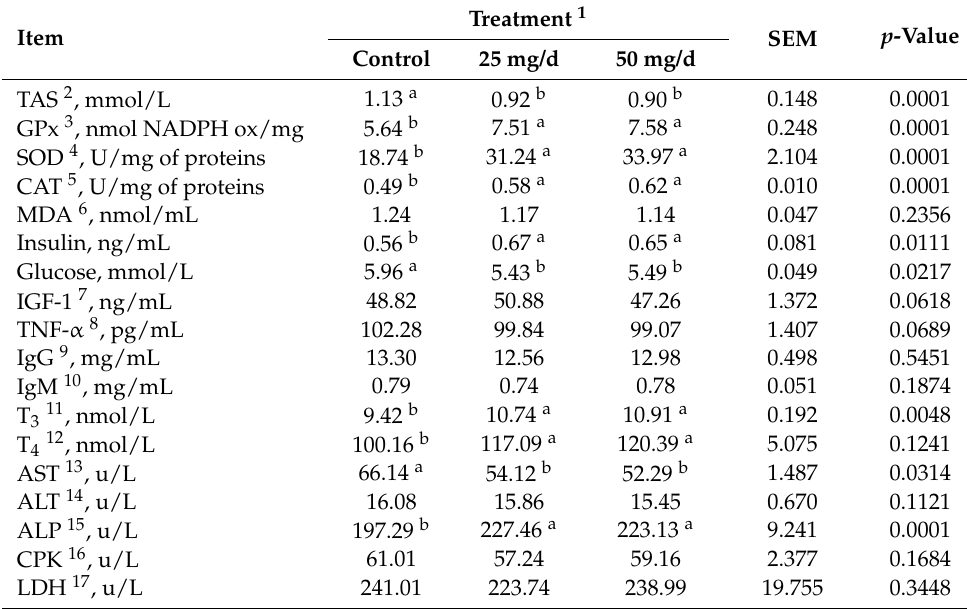
Table 4. The effect of organic iron supplementation on antioxidation status, biochemical and im- munological